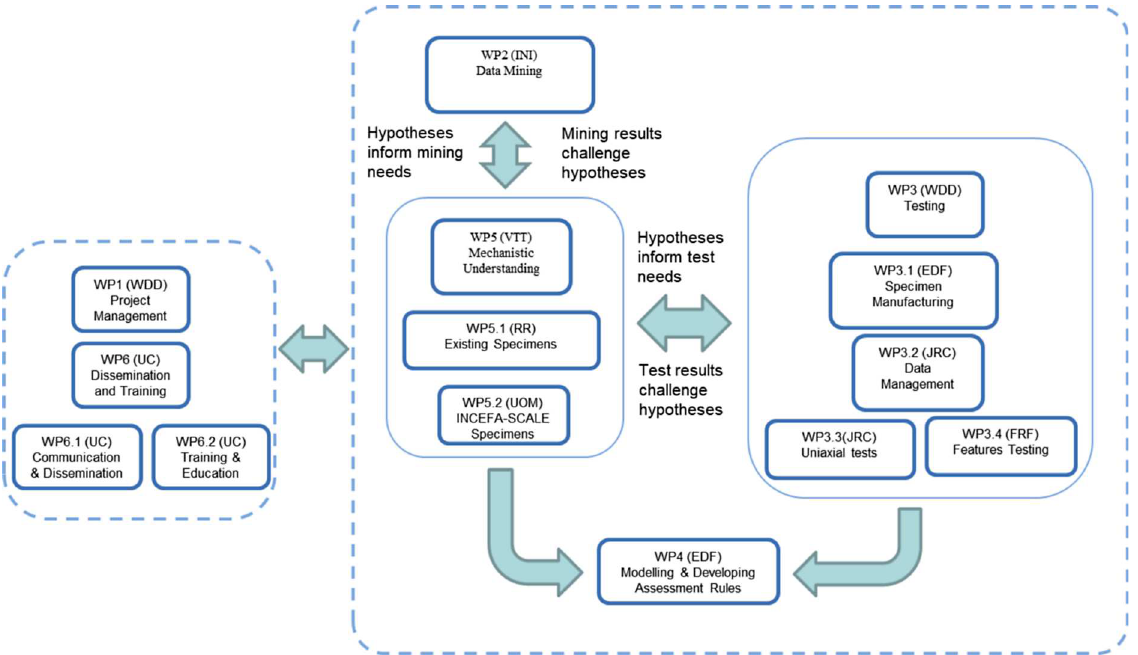
Fig. 4. INCEFA-SCALE work package